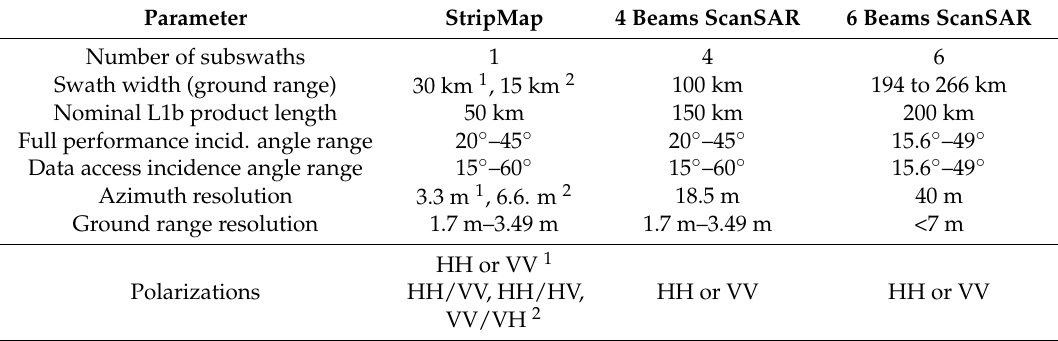
Table 1. TerraSAR-X’s StripMap and ScanSAR mode parameters (modified from [23]).